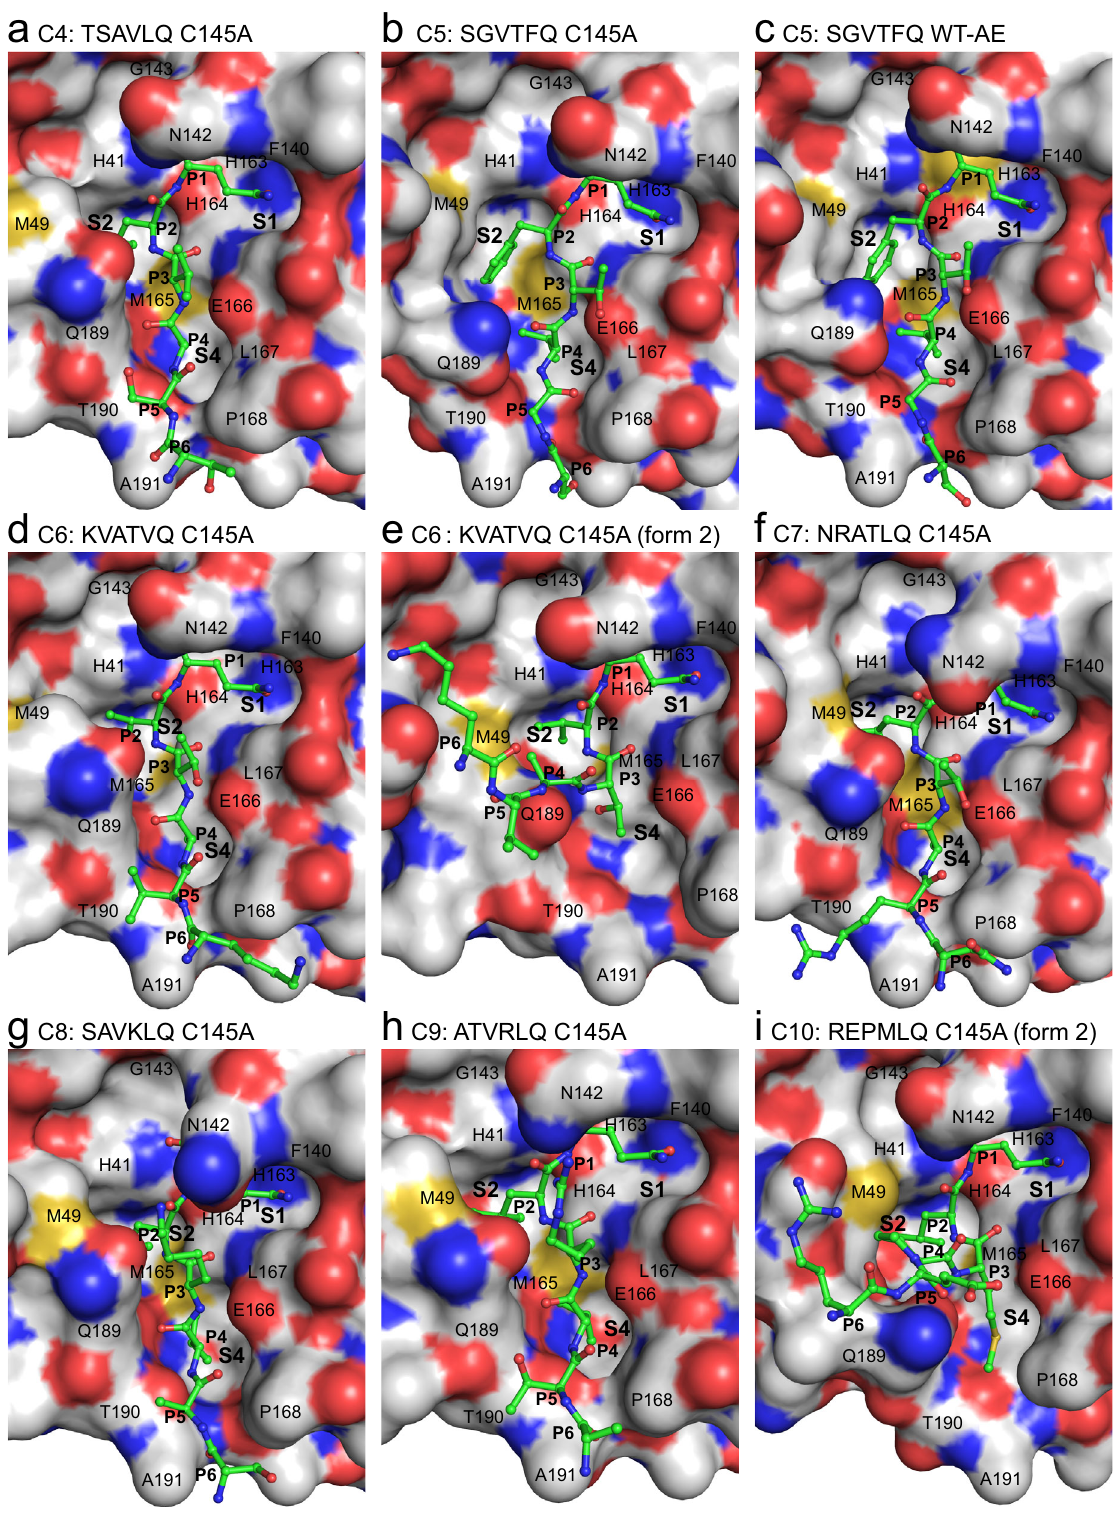
Fig. 2 | X-ray crystallographic structures of SARS-CoV-2 M pro cleavage sites C4 to C10. a , b and d – i showproduct-like complexes with the C145A mutant, c shows an acyl-enzyme (AE) intermediate complex with wild-type (WT) M pro . The com- plementarysubstratespeci fi cityresidues(P6-P1)arelabeledandshownasball-and- stick (carbons are green) bound into the M pro substrate binding groove shown as a molecular surface (carbons are gray). The Schechter – Berger substrate speci fi city